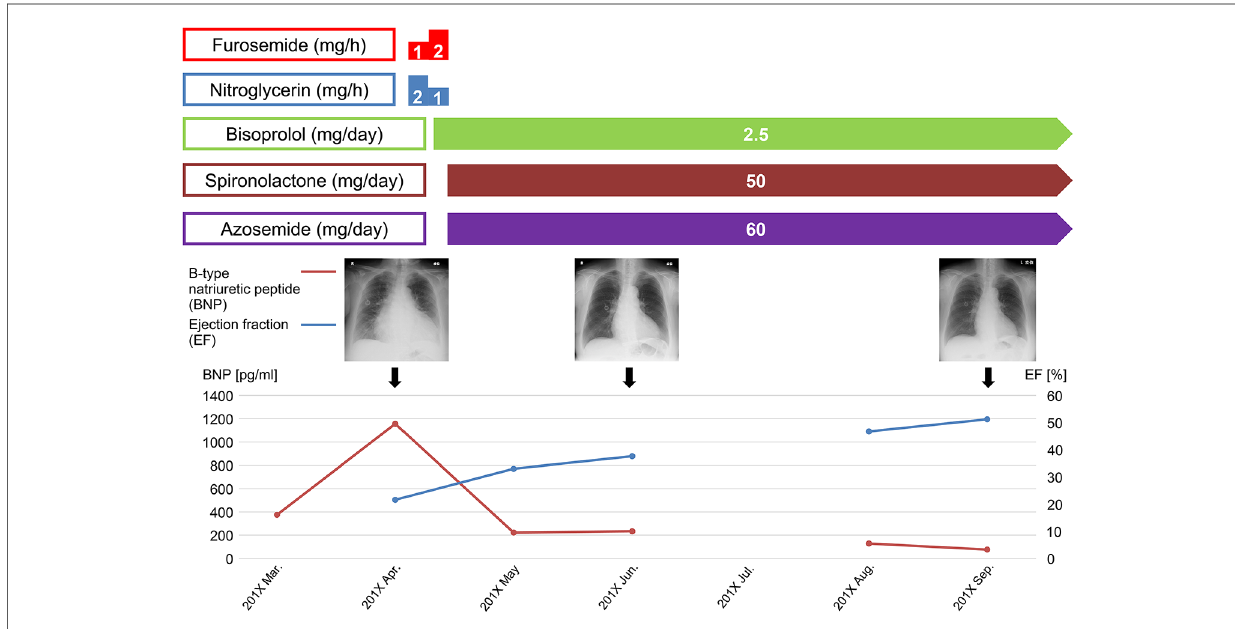
FIGURE 3 The clinical course of congestive heart